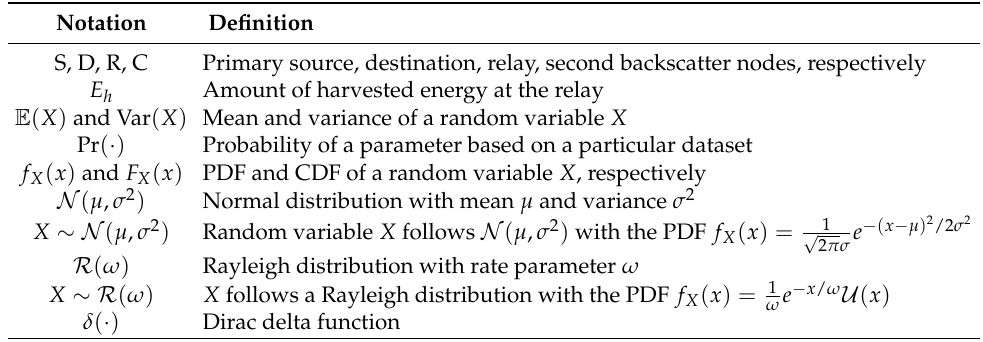
Table 1. List of mathematical symbols used in the